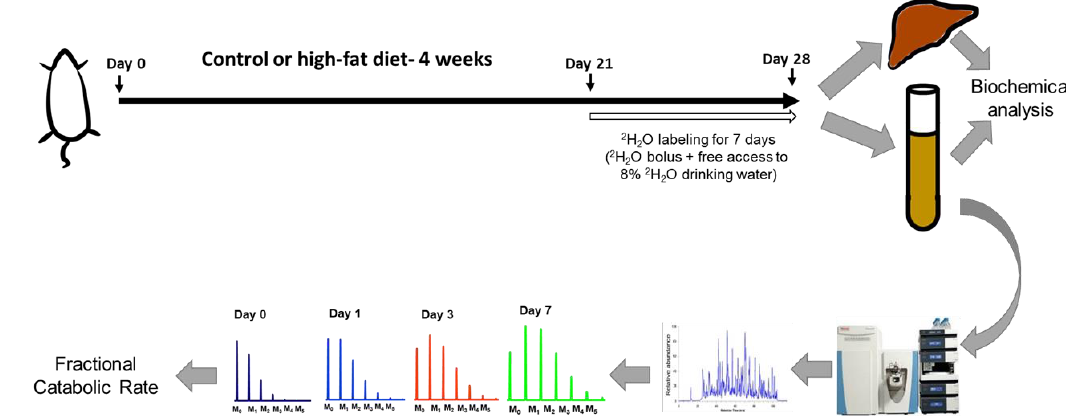
Figure 1. A schematic of the study design. Wild-type C57BL/6J male mice were fed a high-fat diet (HFD) or control diet for four weeks. During the last week of feeding, heavy water was administered to determine the turnover rates of high-density lipoprotein (HDL) proteome. The HDL proteins were isolated, followed by their tryptic digestion and analysis by tandem mass spectrometry. The turnover rate constants of proteins were determined based on their time course of 2 H-labeling. Metabolic changes were evaluated using biochemical analyses of liver and plasma samples.